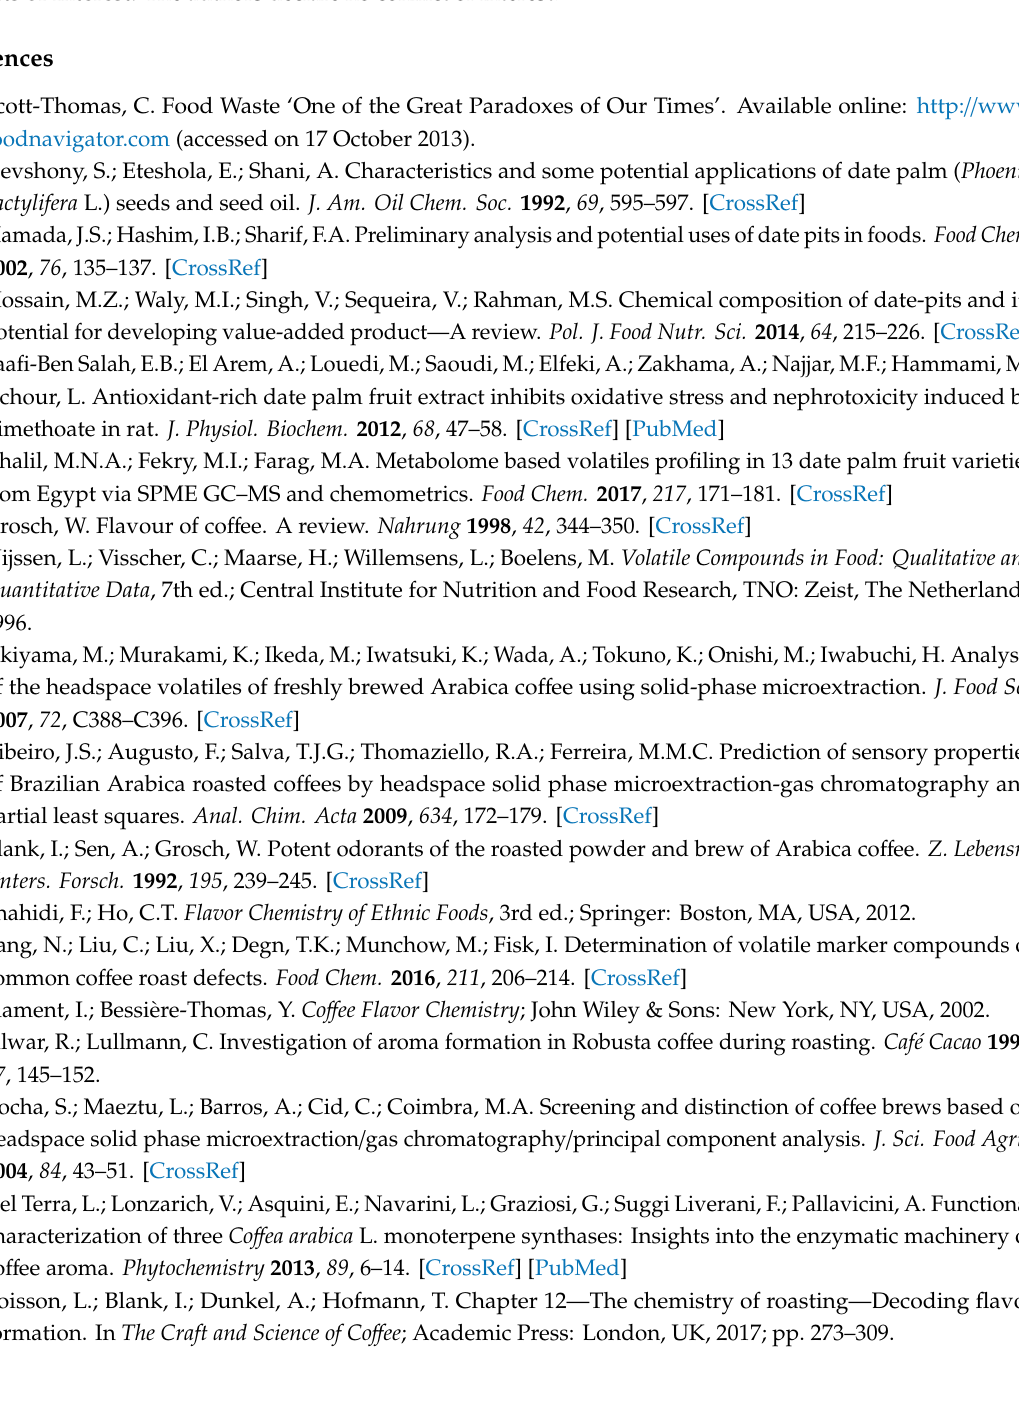
squares crossed by mice and number of rearing during Open Field